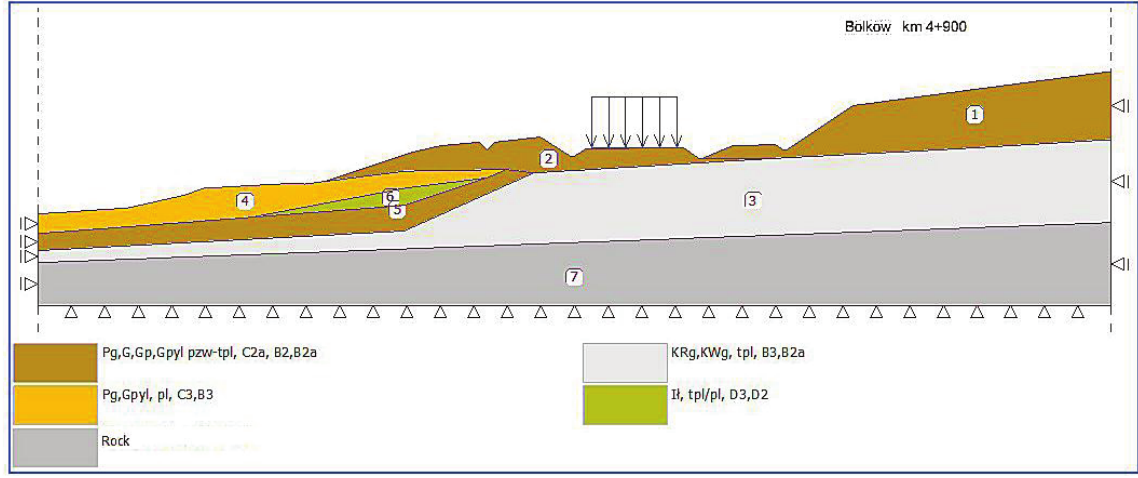
Figure 9. System of ground layers. Phase 2 of calculations – state with road load after the performance of a road excavation